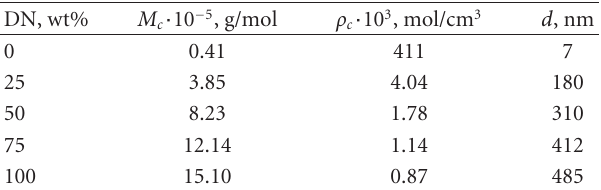
Figure 7: E ff ect of degree of neutralization on macroscopic prop- erties of PAAG xerogels. Table 6: The e ff ect of neutralization degree on PSPP of PAAG